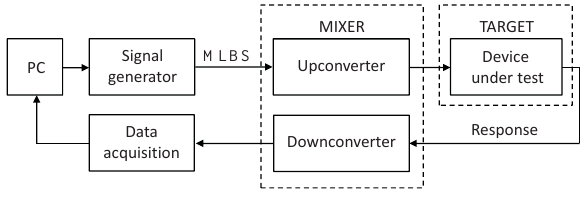
Figure 7: Measurement setup.